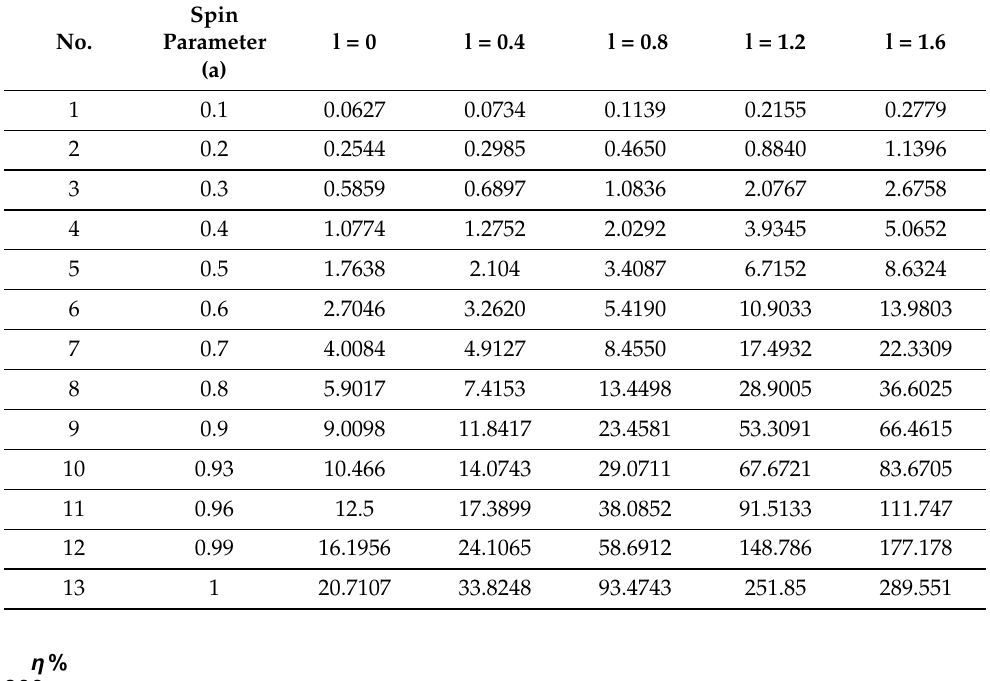
Efficiency of energy extraction for a singular black hole spacetime for different